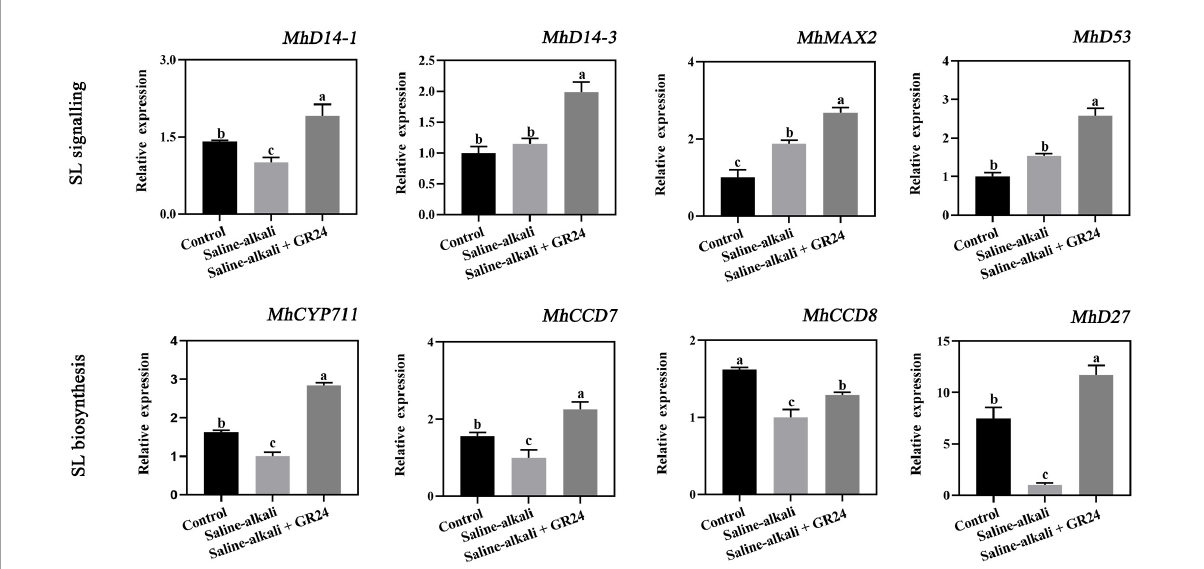
FIGURE9 The expression level of the four genes in SL signal transduction pathway ( MhD14-1 , MhD14-3 , MhMAX2 , and MhD53 ), and four SL biosynthesis genes ( MhCYP711 , MhCCD7 , MhCCD8 , and MhD27 ) under salinity-alkalinity stress and exogenous GR24 treatment for 15 days. The data represent the mean ± SD of three biological replicates. Different lowercase letters indicate significant differences according to Fisher’s least significant difference ( P <